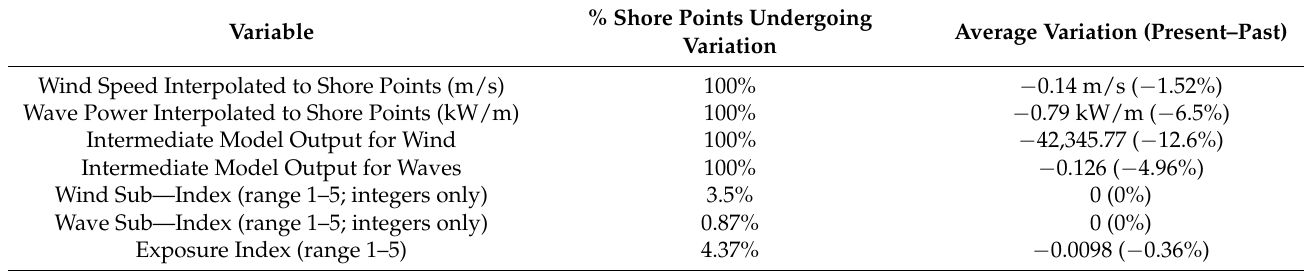
Table 5. Analysis of model sensitivity to variations in climate data inputs between the two 30-year climate periods spanning 1961–1990 and